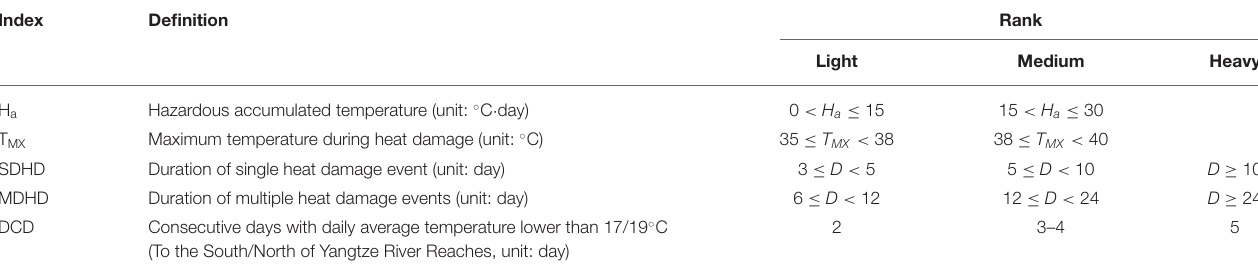
TABLE 2 | Definitions of heat and chilling damage